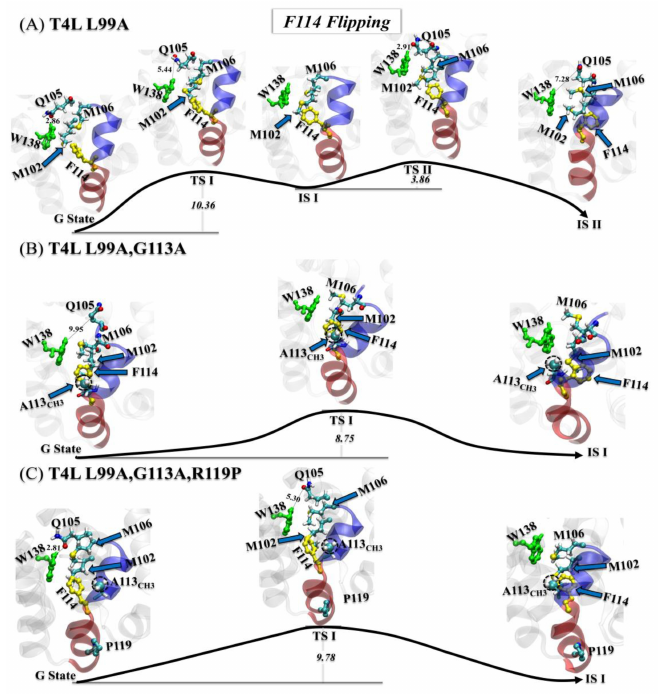
Figure 4. ( A – C ) Mechanisms of the first step (F114 flipping) of the G → E transition for T4L-L99A ( A ), T4L-L99A,G113A ( B ), and T4L-L99A,G113A,R119P ( C ). All transition/intermediate states were identified from the free-energy landscapes in Figure 2A–C, with key residues and structural segments highlighted: α 0 (transparent blue), α 1 (transparent red), F114 (yellow), W138 (green), and A113 CH3 (dashed black circle).